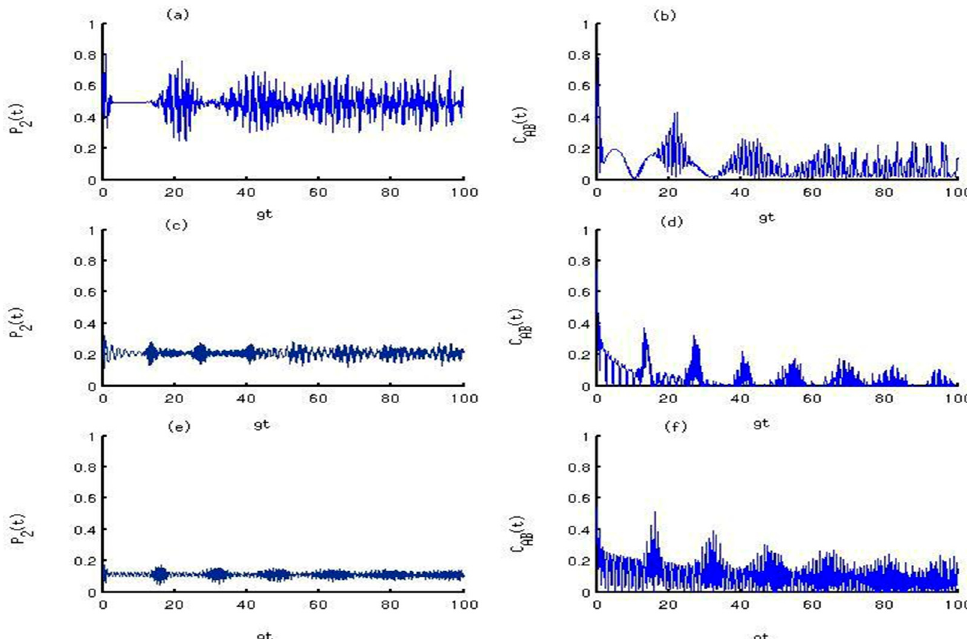
Figure 2. (Color Online) The probability and entanglement are plotted versus the dimensionless time gt for various values of the energy detuning for one-photon transition ( l = 1) in the absence of the atomic motion effect G ( t ) = g with | α | 2 = 10. ( a , c , e ) display the variation of the population for a single-excitation with the time; ( b , d , f ) present the evolution of the concurrence of the donor-acceptor state during the time evolution. ( a , b ) is for ω d = 0; ( c , d ) is for ω d = 2; and ( e , f ) is for ω d =